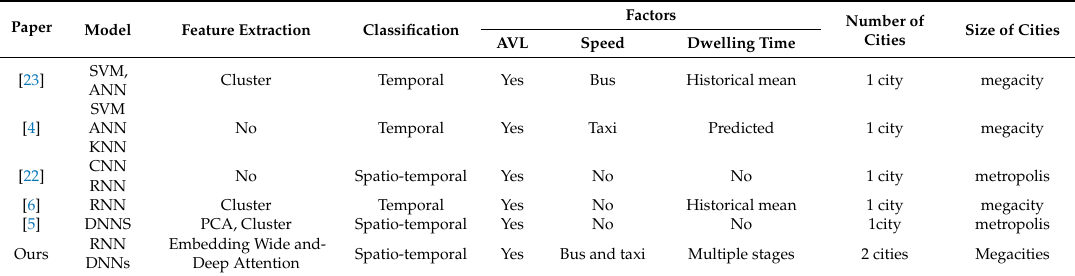
Table 1. A comparison of travel time prediction